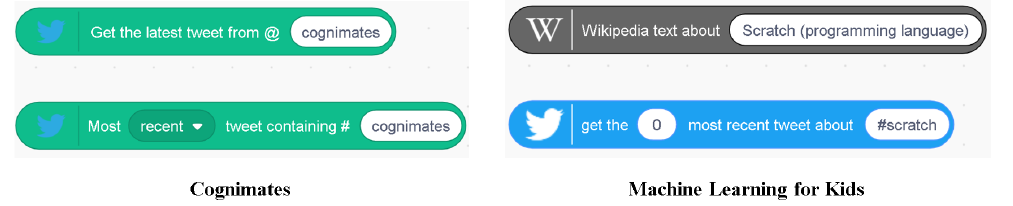
Figure 1. The existing blocks that can scrape data from Twitter or Wikipedia provided by Cognimates (on the left ) and Machine Learning for Kids (on the right